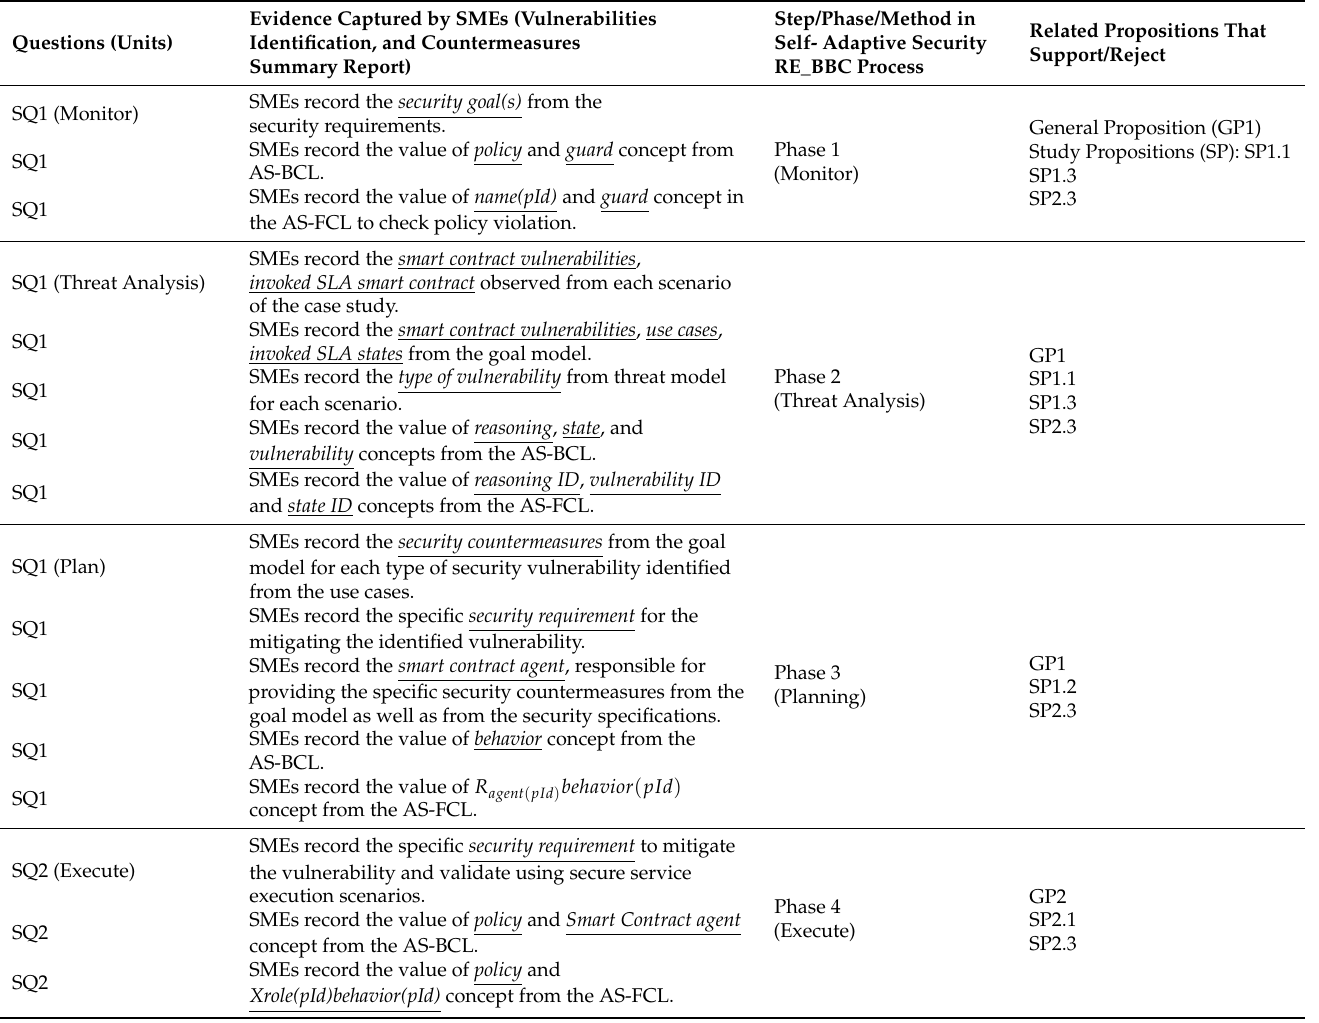
Table 2. Evidence Collection through Vulnerability Identification, and Countermeasures Summary